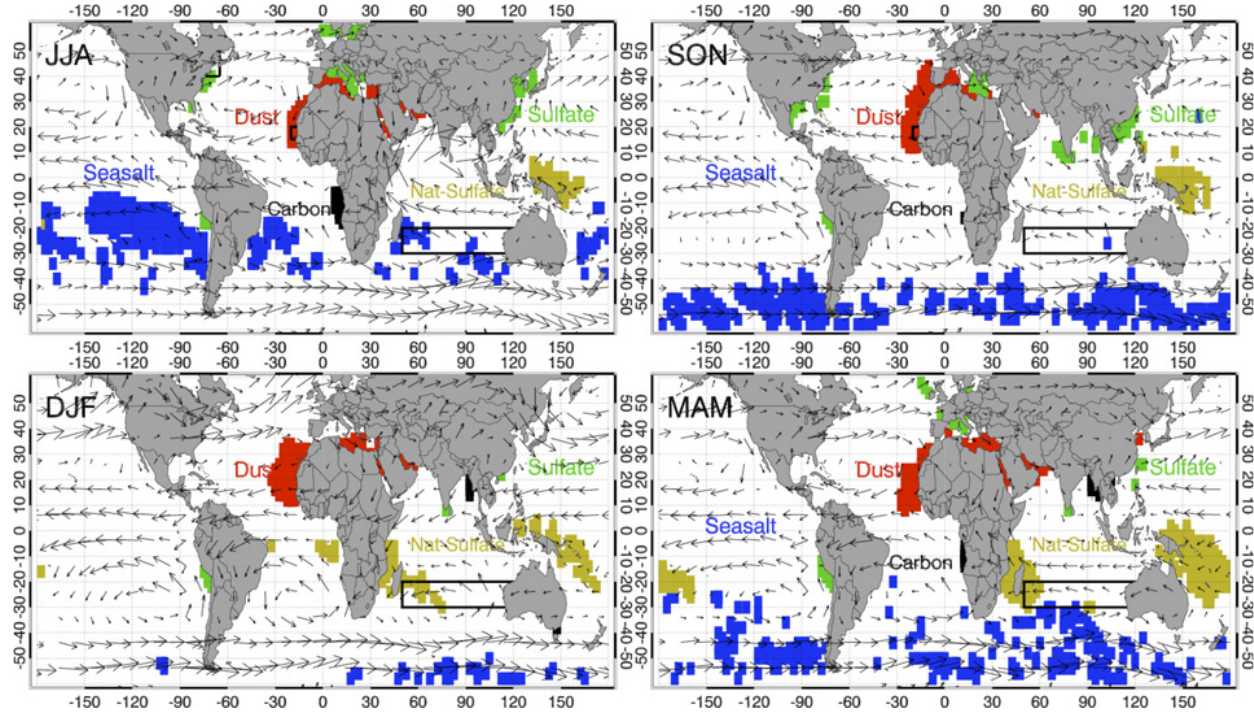
Fig. 1. Global aerosol distributions where at least 80% of the total GOCART AOT is represented by a single aerosol type (sea-salt, dust, natural sulfate, anthropogenic sulfate, or organic+black carbon) over the ocean between June 2006 and May 2007 for June, July, and August (JJA); September, October, and November (SON); December, January, and February (DJF); and March, April, and May (MAM). Black boxes show the regions defined by Kaufman et al. (2005a) corresponding to individual aerosol types (SS: west of Australia, DU: west of Africa, and AN: northeast of the United States). Vectors indicate the seasonally averaged 850-hPa wind speed and direction. et al. (2005a, b) and Yu et al. (2009) used MODIS data from only the Terra satellite when computing their